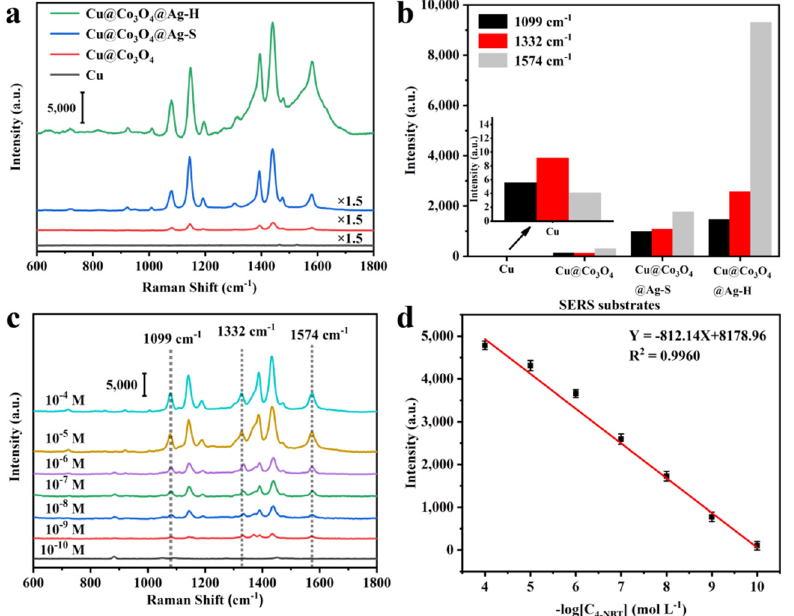
Figure 4. ( a ) Raman spectra of 4-NBT (10 -4 M) on four Cu foam, Cu@Co 3 O 4 , Cu@Co 3 O 4 @Ag-S and Cu@Co 3 O 4 @Ag-H substrates for comparation and ( b ) corresponding intensity distribution of the 1099 cm -1 , 1332 cm -1 and 1574 cm -1 peaks. ( c ) SERS spectra of 4-NBT on the Cu@Co 3 O 4 @Ag-H sub- strate at different concentrations from 10 -4 M to 10 -10 M. ( d ) Relationship between the intensity of the SERS peak at 1332 cm -1 and the 4-NBT concentration; the error bar is based on four parallel SERS spectra.